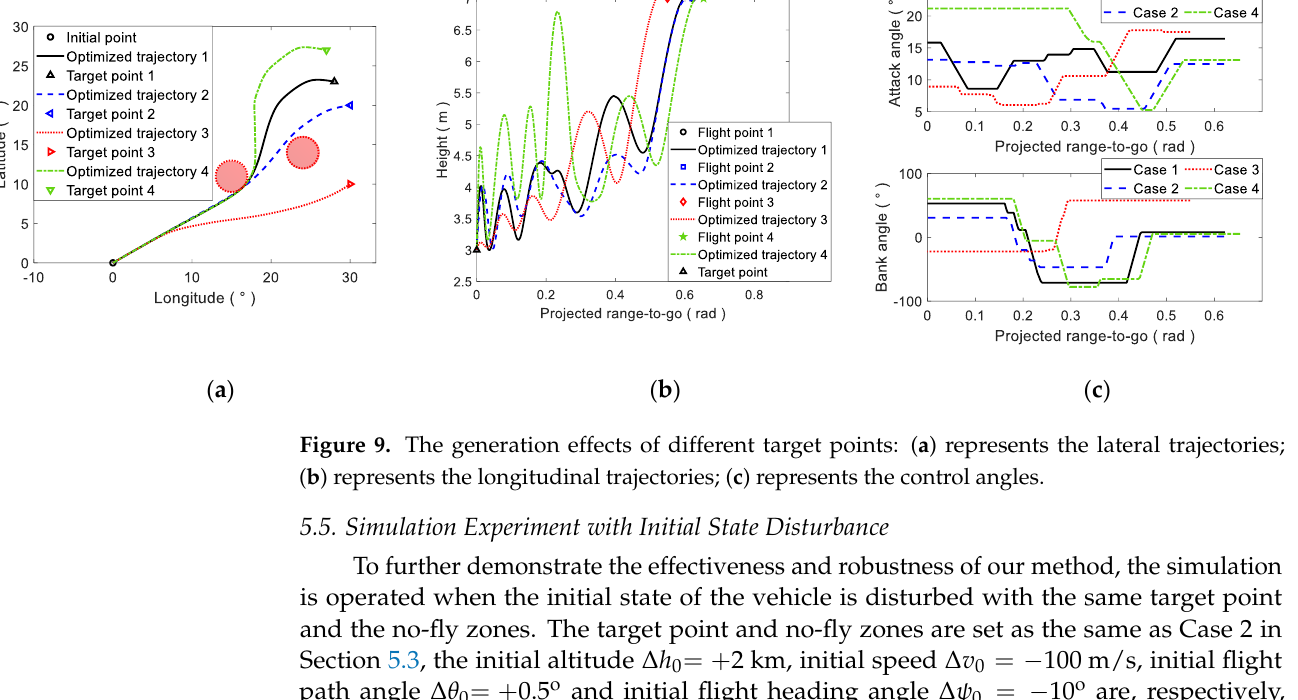
( c ) Figure 10. The generation effects of the initial state with disturbance: ( a ) represents the lateral tra- jectories; ( b ) represents the longitudinal trajectories; ( c ) represents the control angles.